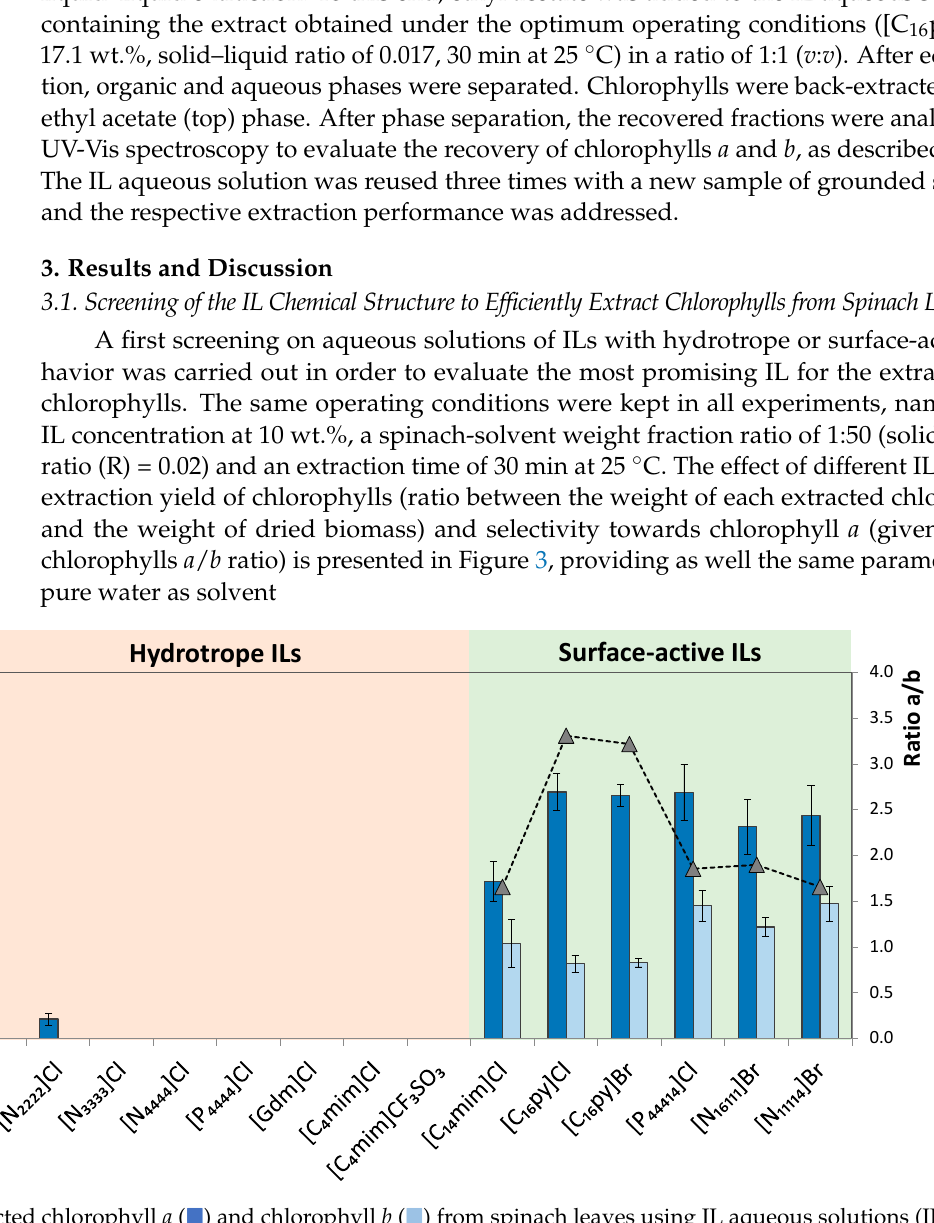
Figure 3. Yield of extracted chlorophyll a ( (cid:4) ) and chlorophyll b ( (cid:4) ) from spinach leaves using IL aqueous solutions (IL at 10wt.%; R = 0.02; 30 min; 25 ◦ C; and 600 rpm) and ratio of chlorophyll a / b ( (cid:78) ).